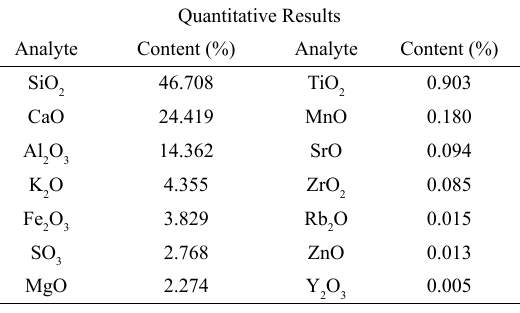
Table 1. Chemical composition of the U-GCW obtained by X-ray fluorescence. Quantitative Results